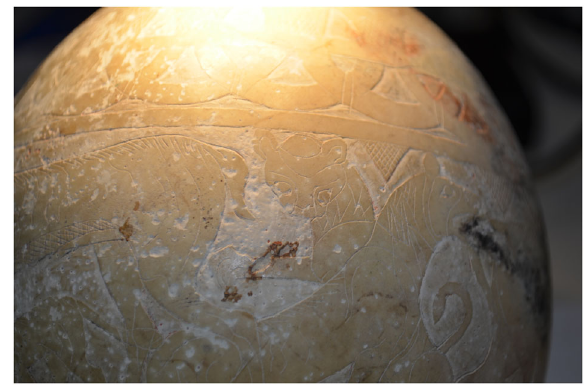
Fig. 2 Incised decoration on an ostrich egg from Vulci, Italy. © T. Hodos and reproduced with permission of the Trustees of the British